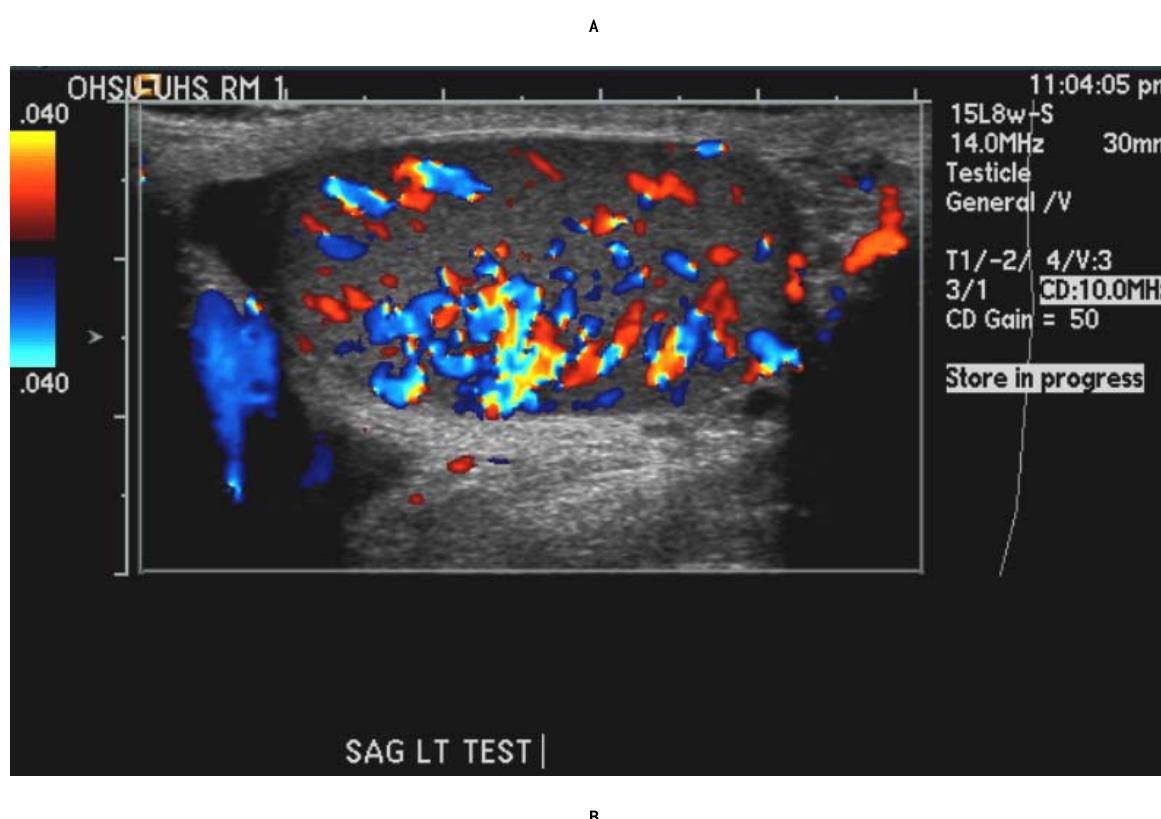
FIGURE 1 . (A) Note the area of hypovascularity in the right testis; (B) normal left